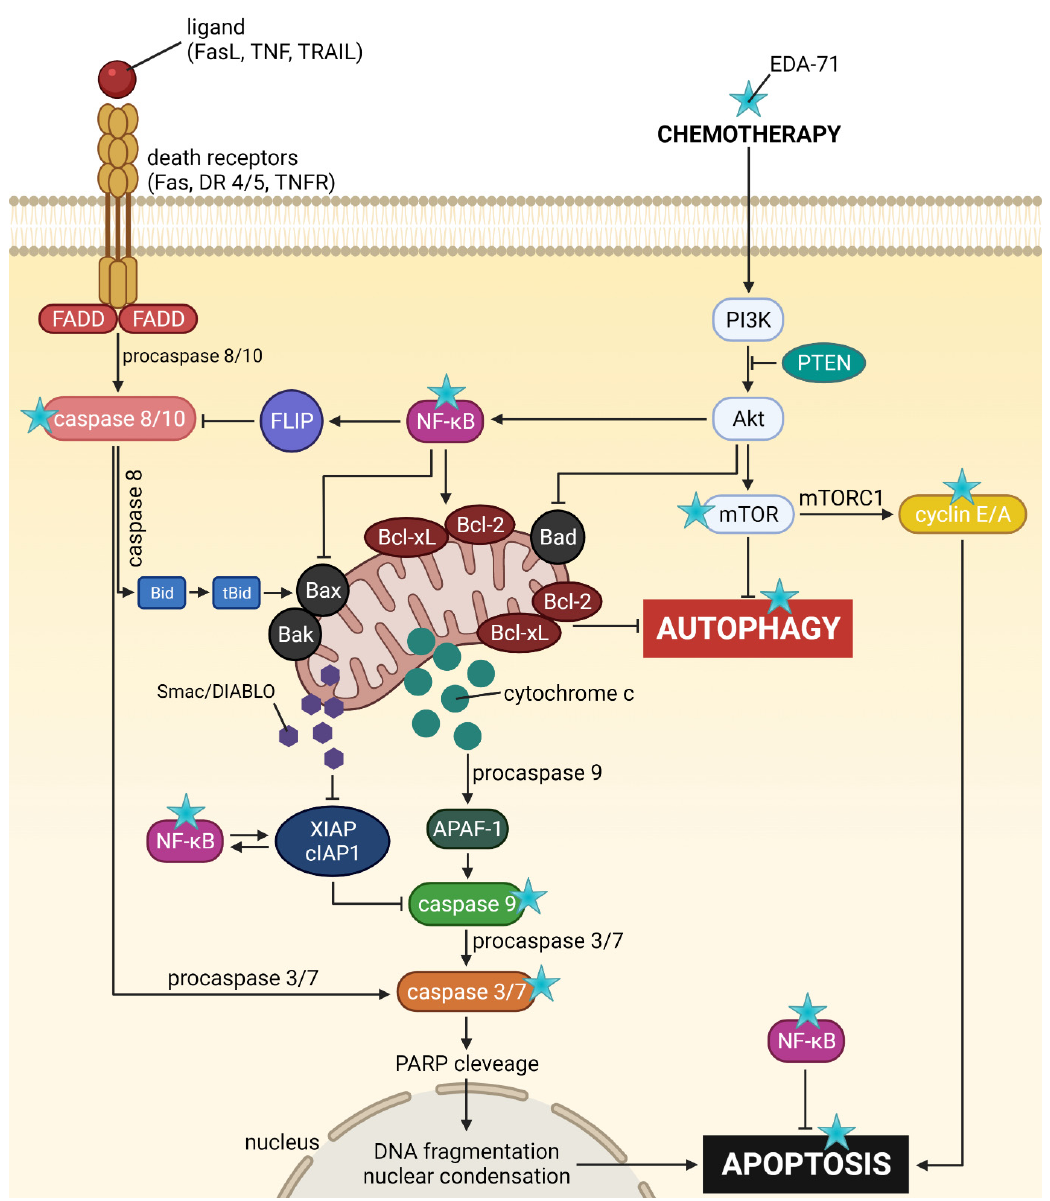
Figure 16. General scheme of the potential molecular anticancer activity of the novel selenoorganic derivative EDA-71.